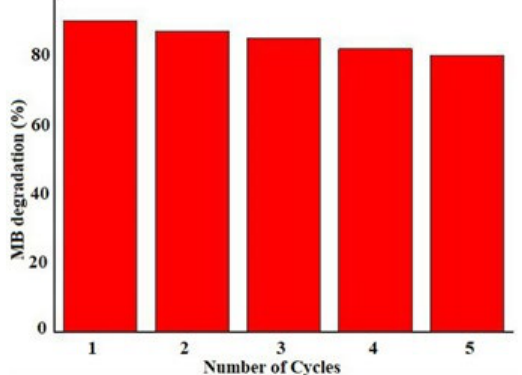
O in different catalytic 2 4